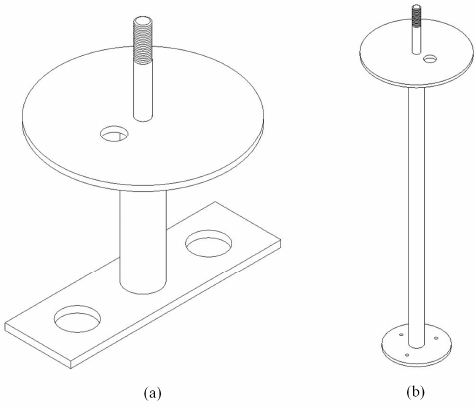
Figure 8. Our proposed low-cost GNSS installation equipment. ( a ) This equipment connects with the main cable. ( b ) This equipment connects with the towers.